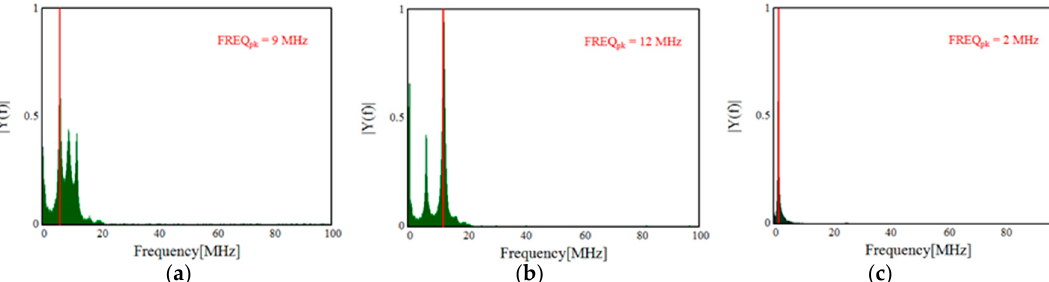
Figure 14. Pulse frequency spectrum of ( a ) internal, ( b ) surface, and ( c ) corona discharges acquired with the HFCT.